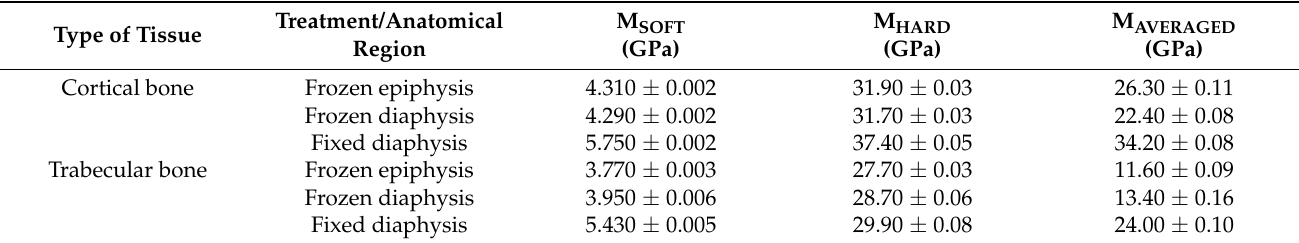
Table 2. Summary of the mean values of longitudinal elastic moduli detected on the different sections. Type of Tissue